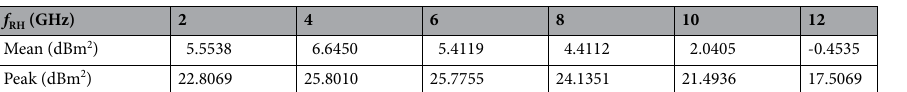
Table 3. RCS indicator of outer wing 1, α = 60°, β = 0°, ω r1 = 0.3142 rad/s, t = 0 ~ 3.857 s.